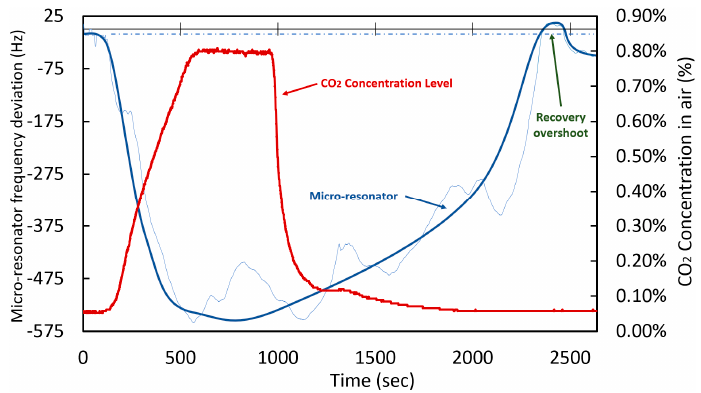
Figure 17. Response of the coated micro-resonator to a 0.8% CO 2 concentration variation.